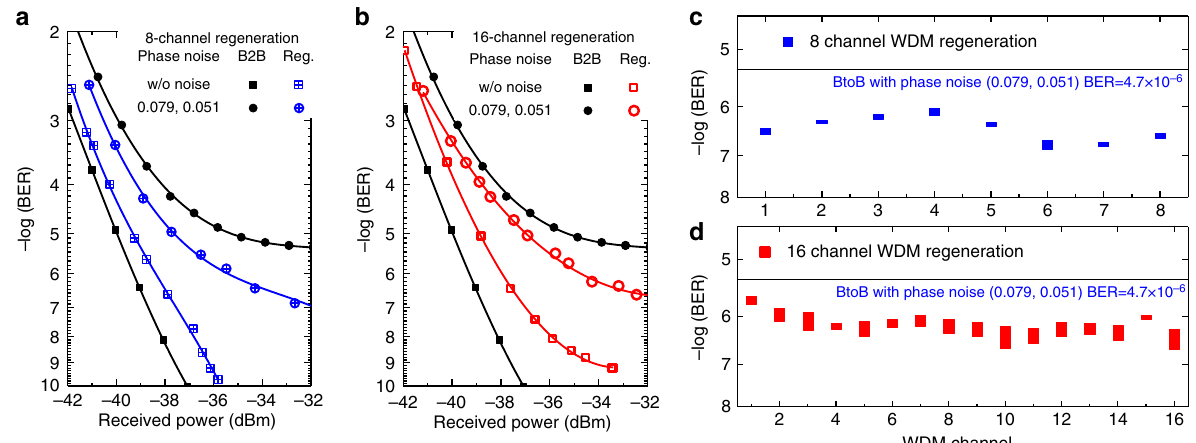
Fig. 7 Experimental WDM phase regeneration results. BER performance of a 8- and b 16-channel regeneration with dual noise emulators ( D 1 , D 2 ), all channel regeneration performance at a received power of − 32 dBm with noise (0.079, 0.051) for c 8-channel and d 16-channel WDM